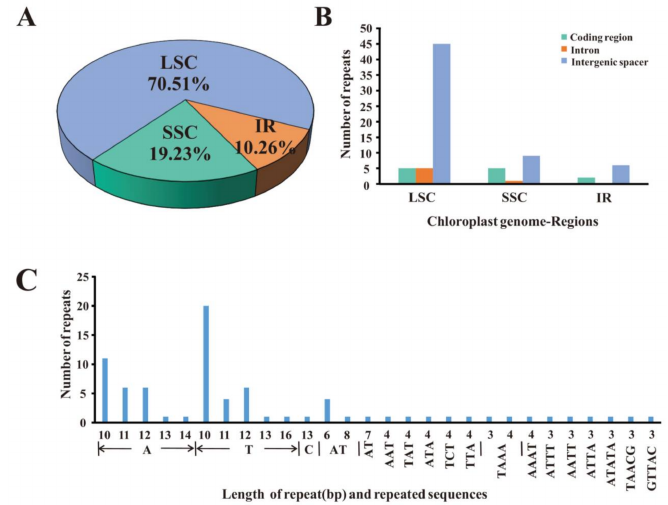
Figure 3. Analysis of simple sequence repeats (SSRs) in the Q. aquifolioides cp genome. ( A ) Frequency of SSRs identified in the LSC, SSC, and IR regions; ( B ) Frequency of SSRs identified in the coding regions, intergenic spacers and introns of the LSC, SSC and IR regions; ( C ) Frequency distribution of different classes of polymer in the cp genome of Q. aquifolioides